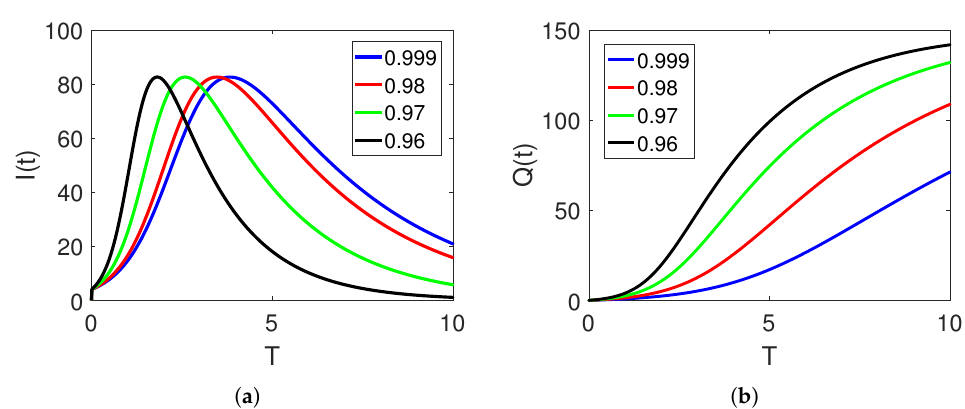
Figure 8. Dynamics of the infected class ( a ) and quarantined class ( b ) on different arbitrary fractional order ς on sub interval [ 0, t 1 ] and [ t 1 , T ] of [ 0, T ] for different time duration.